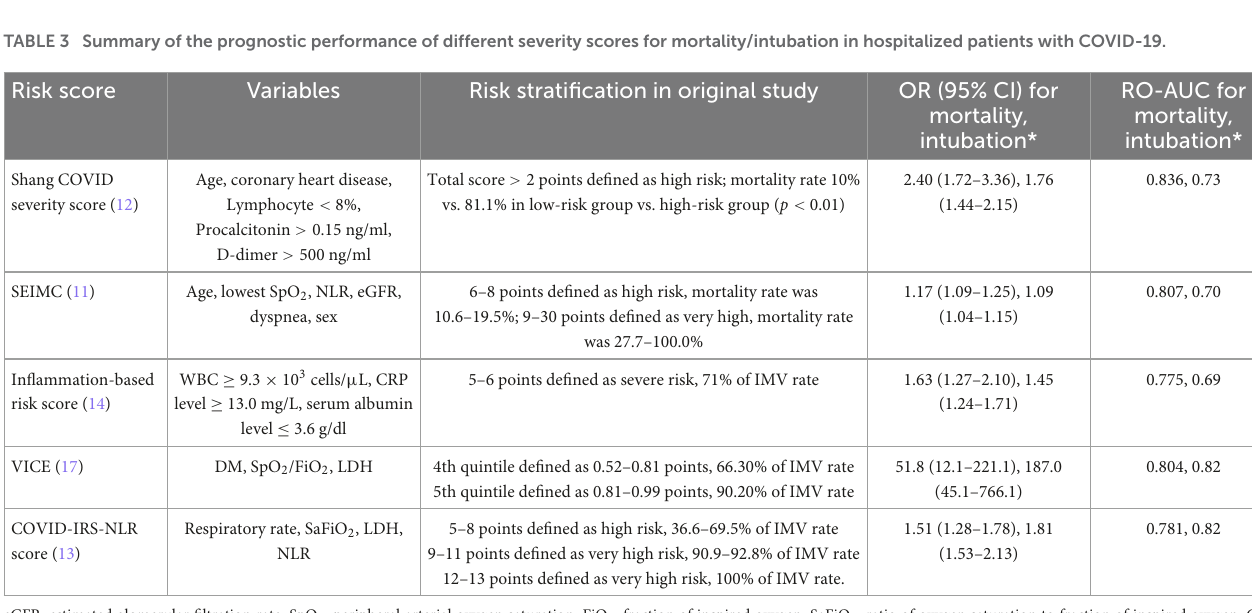
TABLE 3 Summary of the prognostic performance of different severity scores for mortality/intubation in hospitalized patients with COVID-19. Risk score Variables Risk stratification in original study OR (95% CI) for